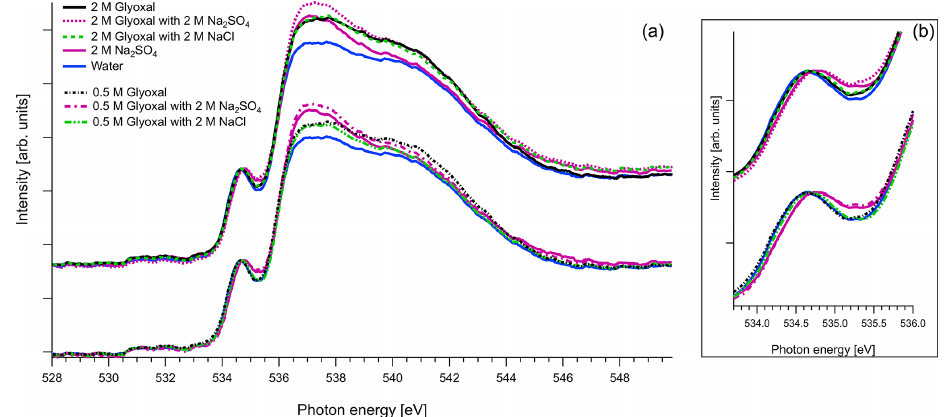
Figure 6. (a) O K-edge spectra of aqueous solutions of glyoxal together with ternary mixtures with 2M of Na 2 SO 4 and 2M of NaCl, normalized to the pre-peak at 535eV. For comparison we also present the O K-edge spectrum of pure water and of aqueous solution with 2M of Na 2 SO 4 . (b) Zoom on the pre-peak of the spectrum.